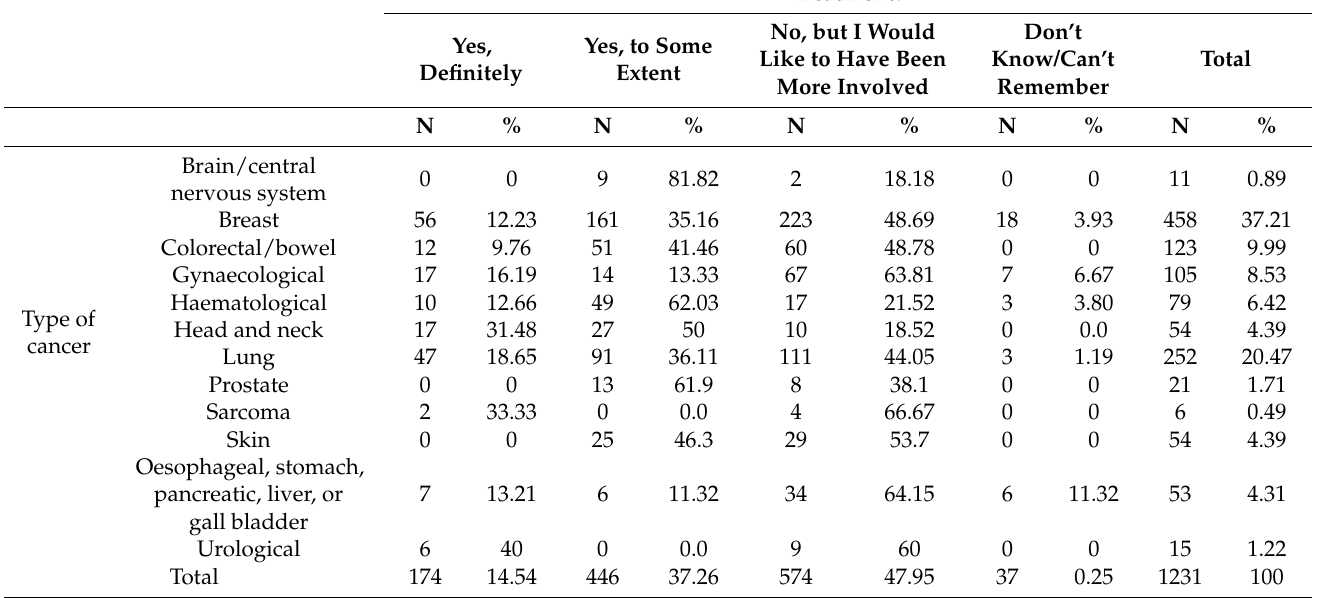
Table 4. Cross tabulation of the patients’ desired involvement in decisions about their care and treatment depending on their type of